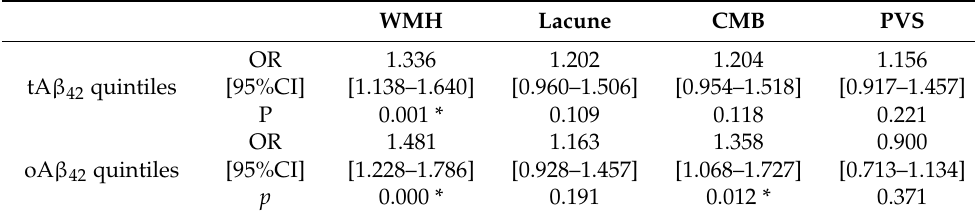
Table 4. Correlations of plasma A β 42 levels to CSVD imaging